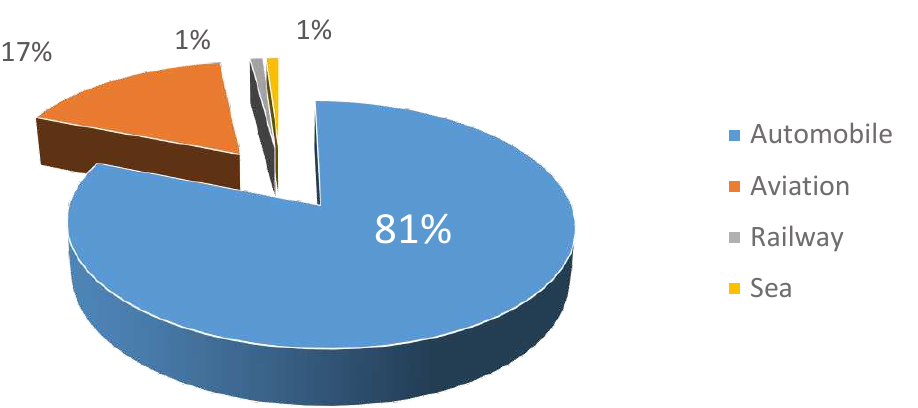
Source: Ministry of Internal Affairs of